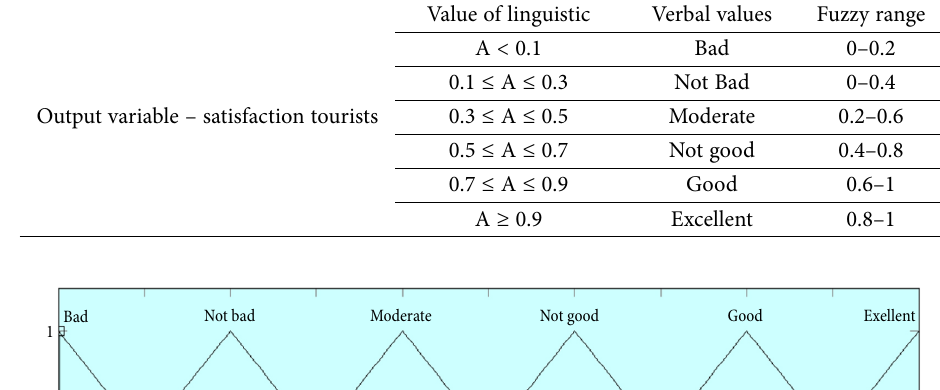
Fuzzy rangeVerbal valuesValue of